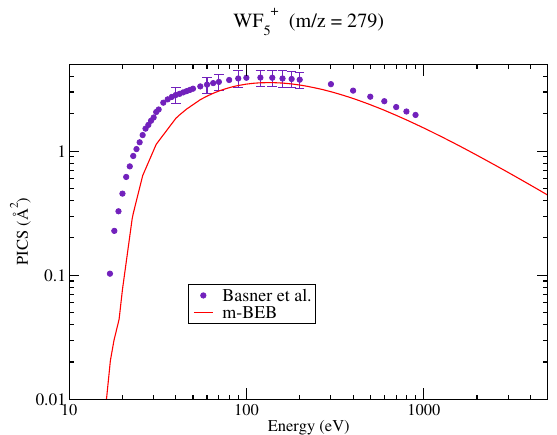
Figure 5. Partial ionization cross sections of SI cations of WF 6 for different m / z values. Line curve, m-BEB results; Circles, SI PICS of Basner et al. [21].